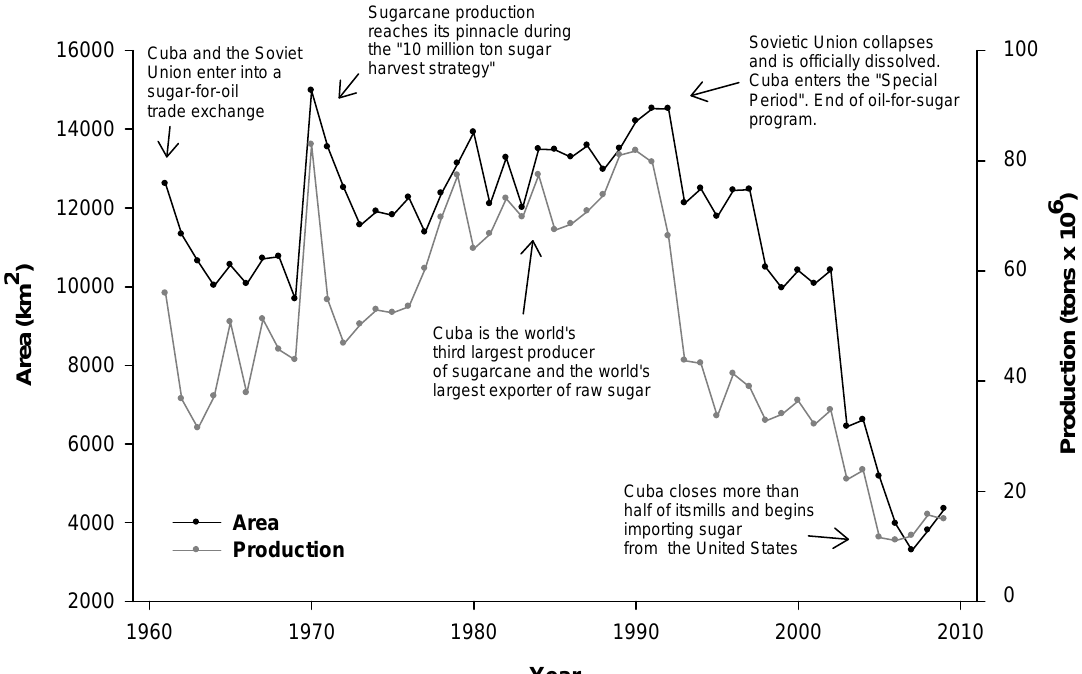
Figure 2. Change in sugarcane production (in tons) in Cuba from 1961 to 2009. Data used to construct this figure was obtained from FAOSTATS